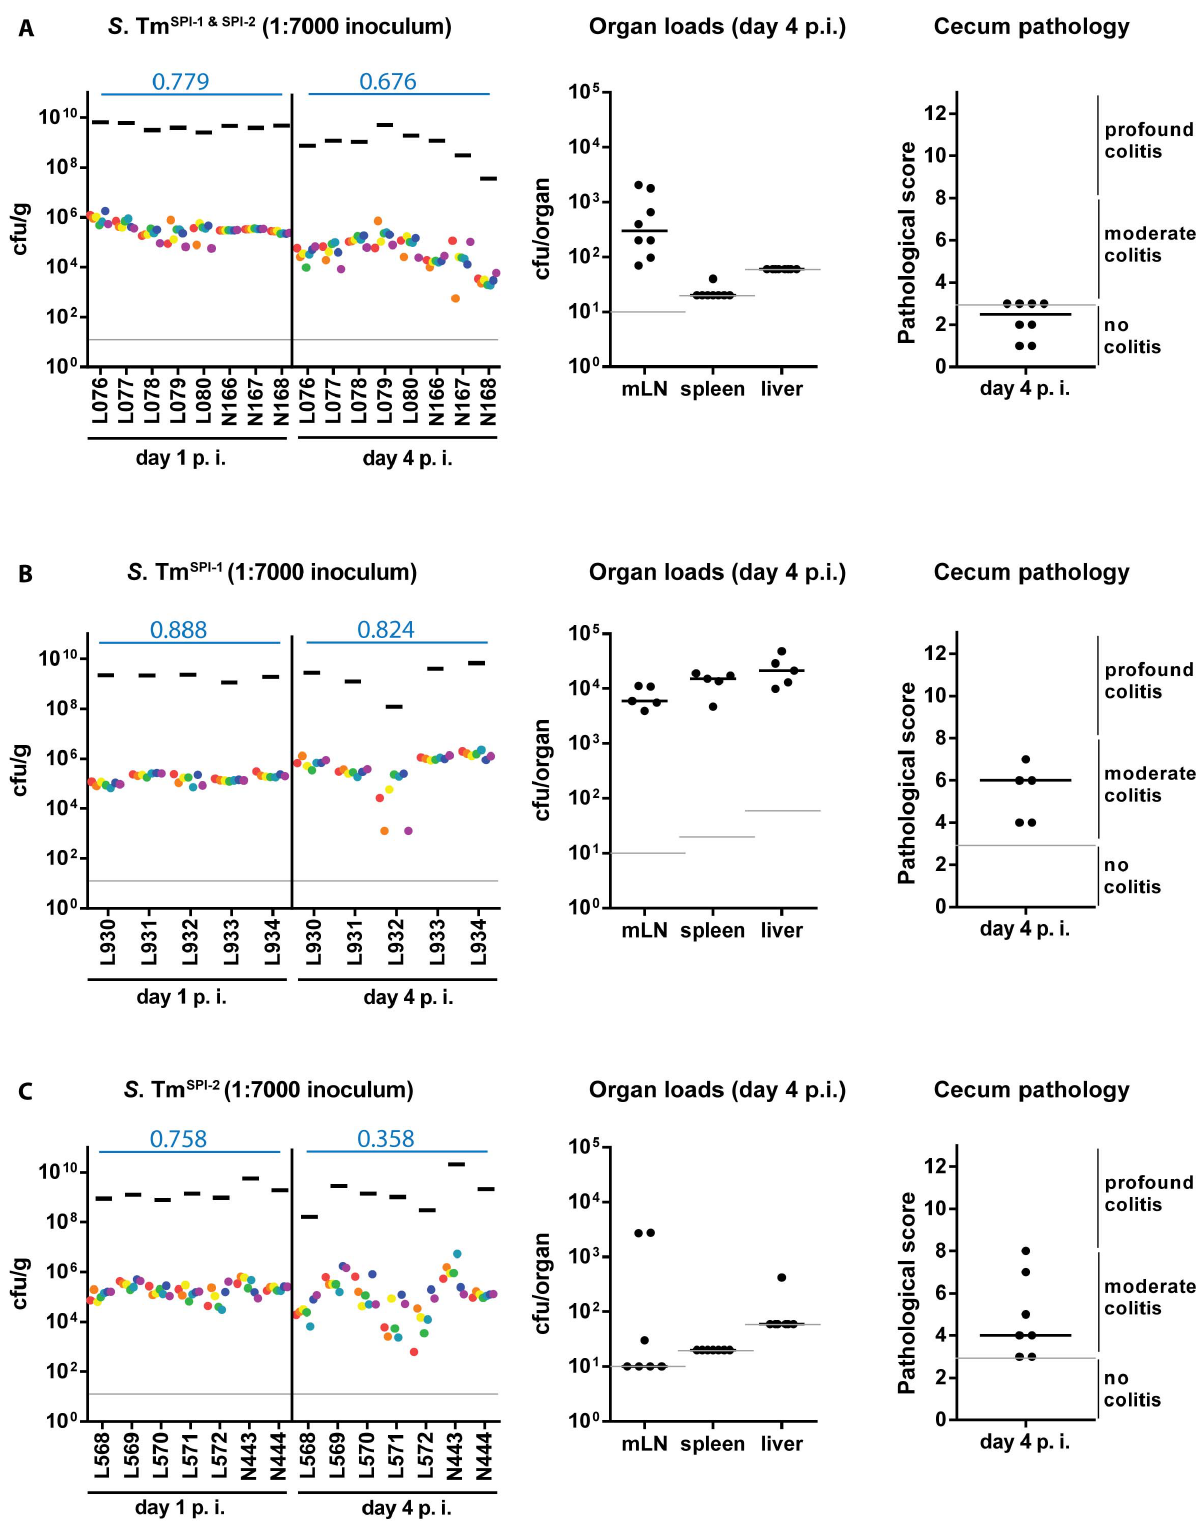
Fig. 3. WITS diversity loss is inflammation-dependent. Streptomycin-pretreated C57BL/6 mice were orally infected with a WITS cocktails in the dilution 1:7000 in different strain backgrounds: (A) S. Tm SPI-1 & SPI-2 , (B) S. Tm SPI-1 and (C) S. Tm SPI-2 and WITS compositions throughout the infection process were monitored by rtqPCR. For each conditions, organ loads and cecum pathology at day 4 p. i. were monitored. Grey lines depict the detection limit for plating (10 cfu/g for feces, cecal content and mLN, 20 cfu/organ for spleen and 60 cfu/organ for liver). Blue numbers indicate the median of the evenness indices of single mice.